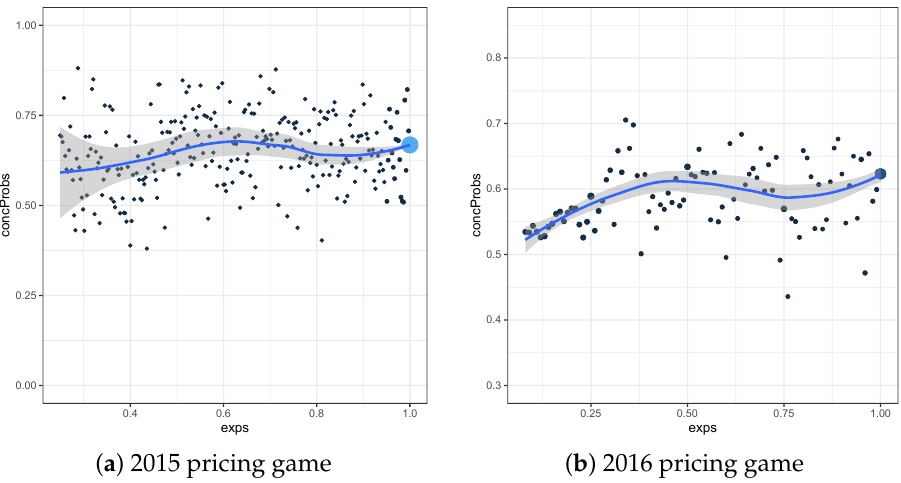
≈ ( λ ,0.05 ) based on the dataset of the 2015 and 2016 pricing Figure 7. Weighted-mean-plot for ˆC kM ,0,1 + game. It is obtained by using the number of clusters that resulted in the highest